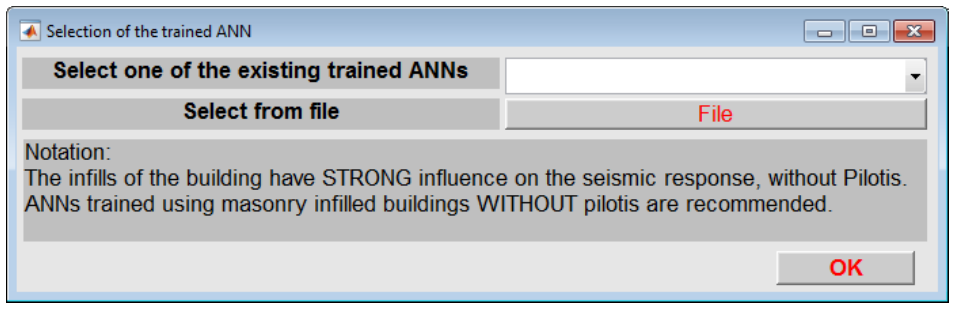
Figure 11. The file selector activated for the selection of the trained MFPNN.